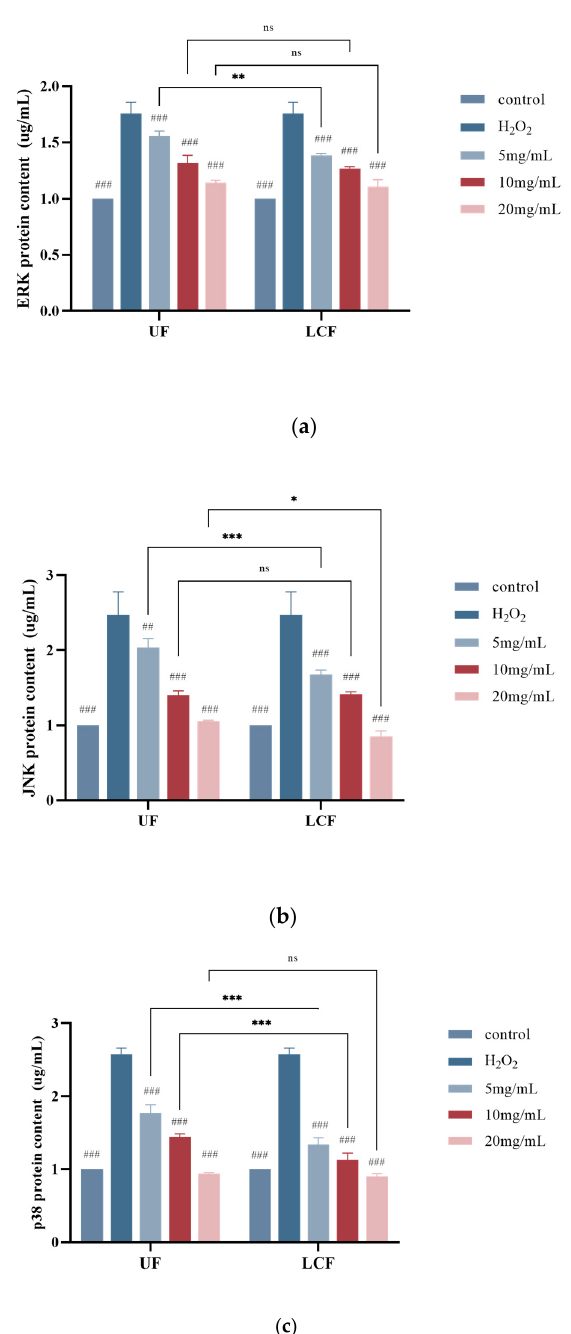
Figure 10. Effects of UF and LCF on MAPK signaling pathway: ( a ) effects on ERK protein content; ( b ) effects on JNK protein content; ( c ) effects on p38 protein content. UF: unfermentation; LCF: single microbial fermentation with L. curvatus . Analysis of significant differences between each group and H 2 O 2 model group, ##: p < 0.01; ###: p < 0.001.; comparison of each group between UF and LCF, *: p < 0.05; **: p < 0.01; ***: p < 0.001 ; ns: p > 0.05.